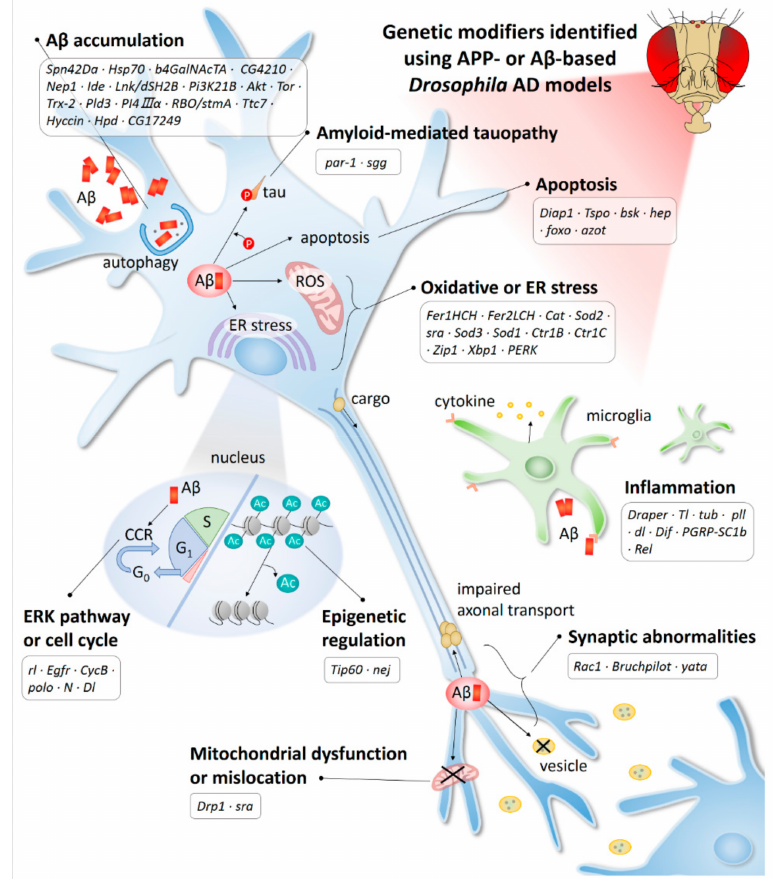
Figure 2. AD-related mechanisms identified using the APP-or A β -based Drosophila model. Ac,